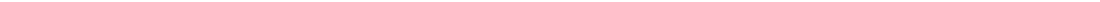
Fig. 3 The two types of HS clusters and CAME-AIS analysis of Xenopus GAGs. a – c The distinct distributions of the two types of HS at a cell boundary in the DMZ. Xenopus gastrula (st. 11.5) embryos were immunostained with directly fl uorescent-labeled NAH46 and HepSS-1 antibodies. White arrowheads, overlap of NAH46 and HepSS-1 staining. Orange arrowheads, HepSS-1 staining inside the cell. Fluorescence intensities of N- acetyl HS (NAH46 epitope, green) and N- sulfo HS (HepSS-1 epitope, magenta) were quanti fi ed similarly to Fig. 2f – k ( b , c ). d , e ndst1 mRNA ( d ) or MO ( e ) was coinjected with mRFP mRNA or FITC- dextran, respectively, as a tracer into the animal pole region of a ventral blastomere at the 4- or 8-cell stage. Injected embryos were fi xed at st. 11.5, and immunostained for N- acetyl-rich or N- sulfo-rich HS. The staining intensities of HS were measured as exempli fi ed in Supplementary Fig. 4b and normalized average intensities of the HS staining are presented as graphs (mean ± s.e.m.). Statistical analysis was performed with t -test (* p < 0.05, ** p < 0.01, *** p < 0.001, NS, not signi fi cant). Numbers of measured cell boundaries were as indicated on the top of the graphs. d Effects of ndst1 overexpression on the HS clusters. White arrowheads indicate stronger staining compared with open arrowheads. e Effects of ndst1 knockdown with ndst1 MO on the HS clusters. Upper panels, white arrowheads indicate stronger staining compared with open arrowheads. Lower panels, white arrowheads indicate no apparent difference in the HS staining at the boundary between tracer-negative or -positive cells. f Cellulose acetate membrane electrophoresis (CAME) of GAGs. Indicated GAGs were stained with alcian blue. g CAME-alcian-immunostaining (CAME-AIS) of Xenopus GAGs. Based on the charge-densitydependent separation of CDSNAc HS and CDSNS HS, Areas 1 through 5 were determined. It is likely that HS in Area 3 corresponds to N- acetyl-rich HS, and that HS in Area 4 corresponds to N- sulfo-rich HS. Images are a representative of at least two independent experiments. Amounts of mRNA (ng/embryo): mRFP , 0.5; ndst1 , 0.020 ( d ), or 0.013 ( e ). Amounts of MOs (ng/embryo): std MO and ndst1 MO, 14. Scale bars, 20 μ m. a.u., arbitrary